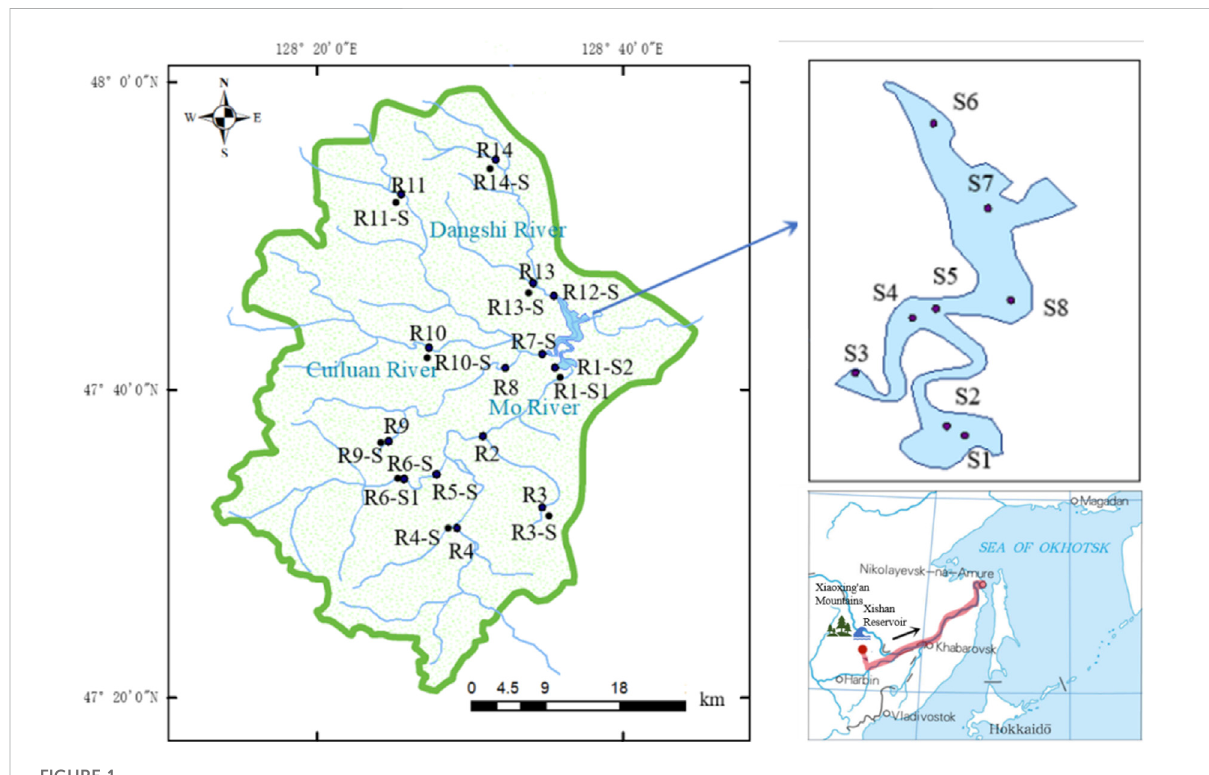
FIGURE 1 Study area and location of the sampling